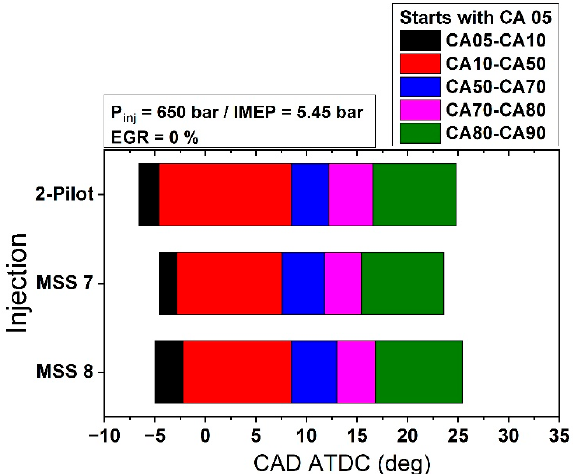
Figure 7. Combustion phases of the two-pilot injection strategy and the two MSS injection strategies.